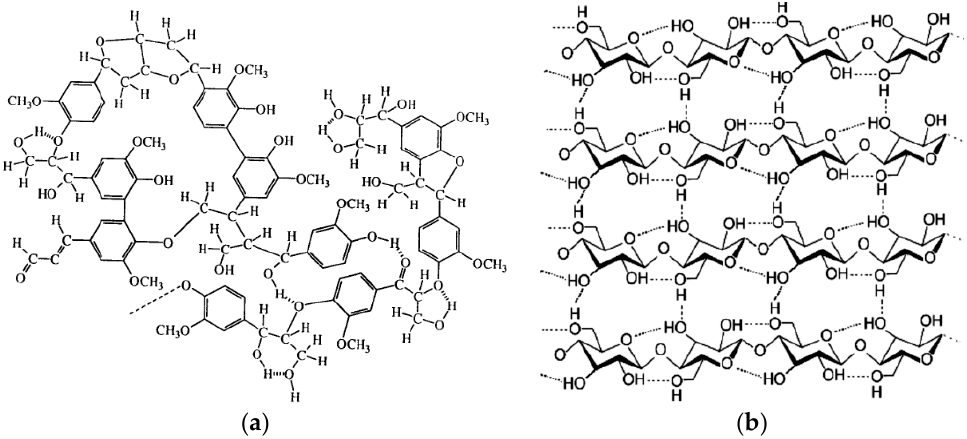
Figure 3. Chemical structures of: ( a ) Lignin [22]; ( b ) cellulose [22].